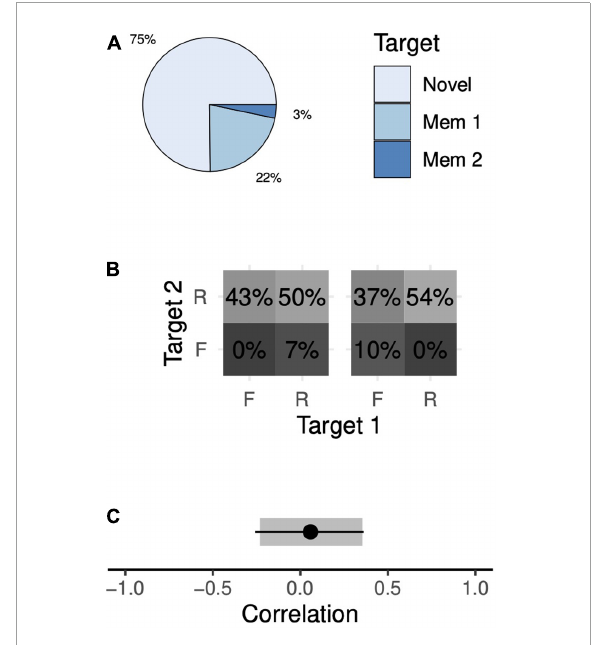
FIGURE5 Target choice probabilities and memory probabilities during the 2-item sequential task. Format identical to Figure 4